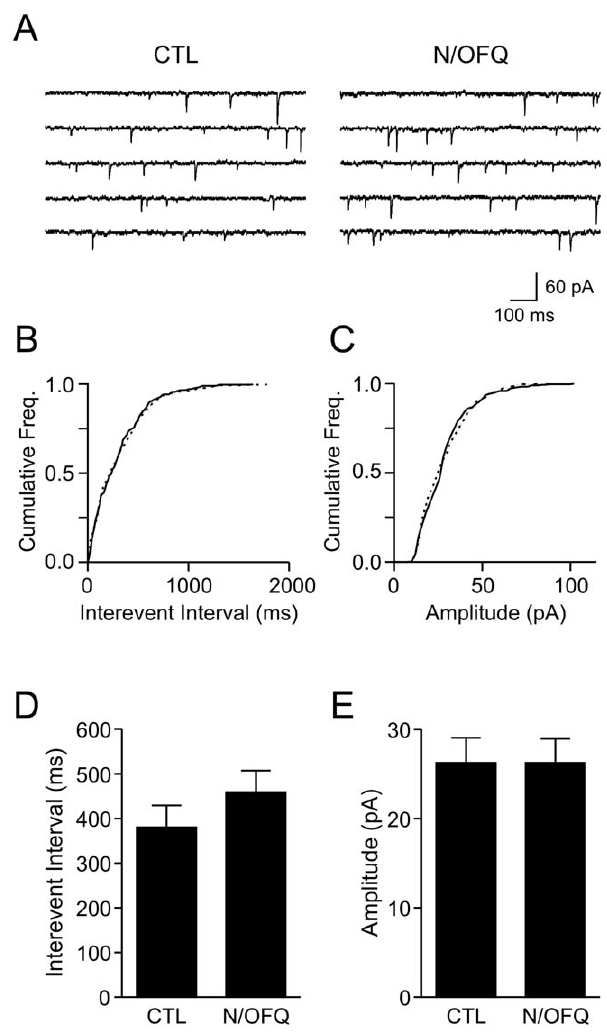
Figure 5. N/OFQ does not consistently modulate excitatory transmission to orexin neurons. A : mEPSC traces from a represen- tative orexin neuron before (control: CTL) and during N/OFQ (0.3 m M, 5 min) application, showing a lack of effect. B-C : Cumulative frequency (freq.) graphs for mEPSC interevent interval ( C ) and amplitude ( D ) for the cell shown in A . Solid and broken lines represent CTL and N/OFQ conditions, respectively. D-E : Grouped data (n=8) of mEPSC interevent interval ( D ) and amplitude ( E ) in control and